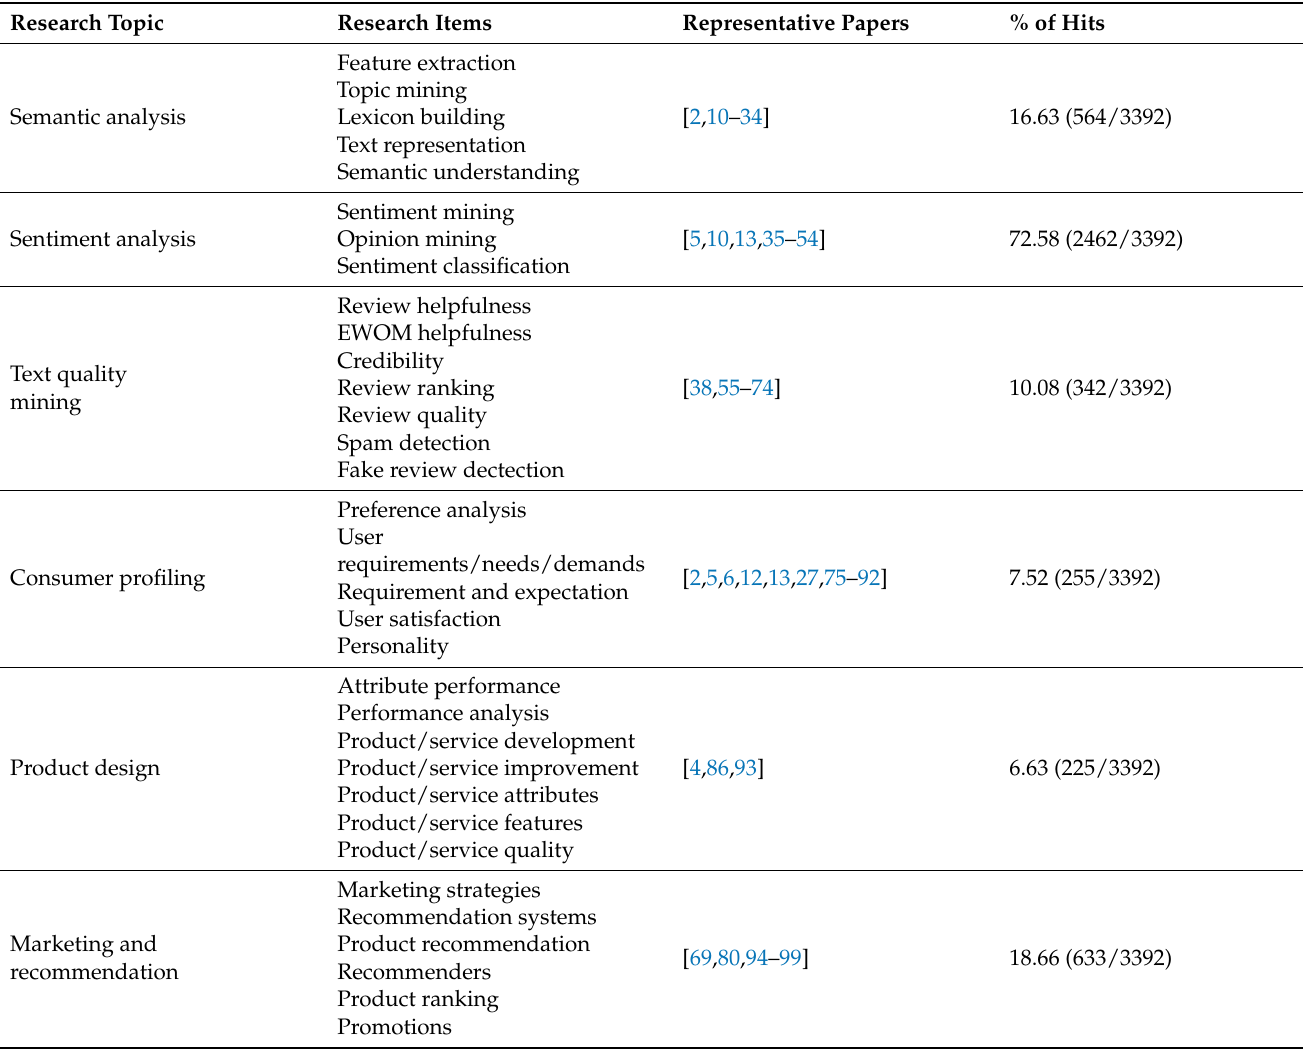
Table 3. Thematic analysis and share of search